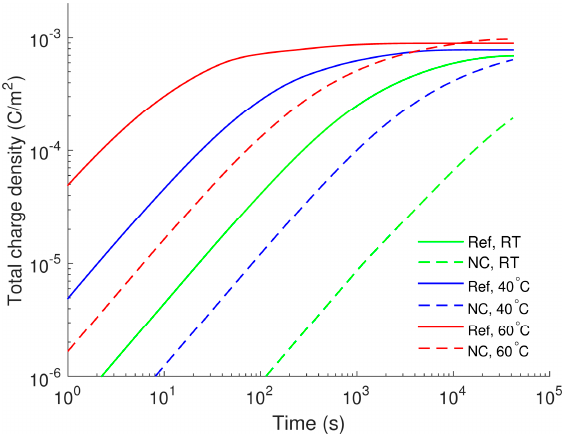
Figure 6. Electric field distributions in LDPE without (Ref) and with (NC) nanofillers at room temperature.